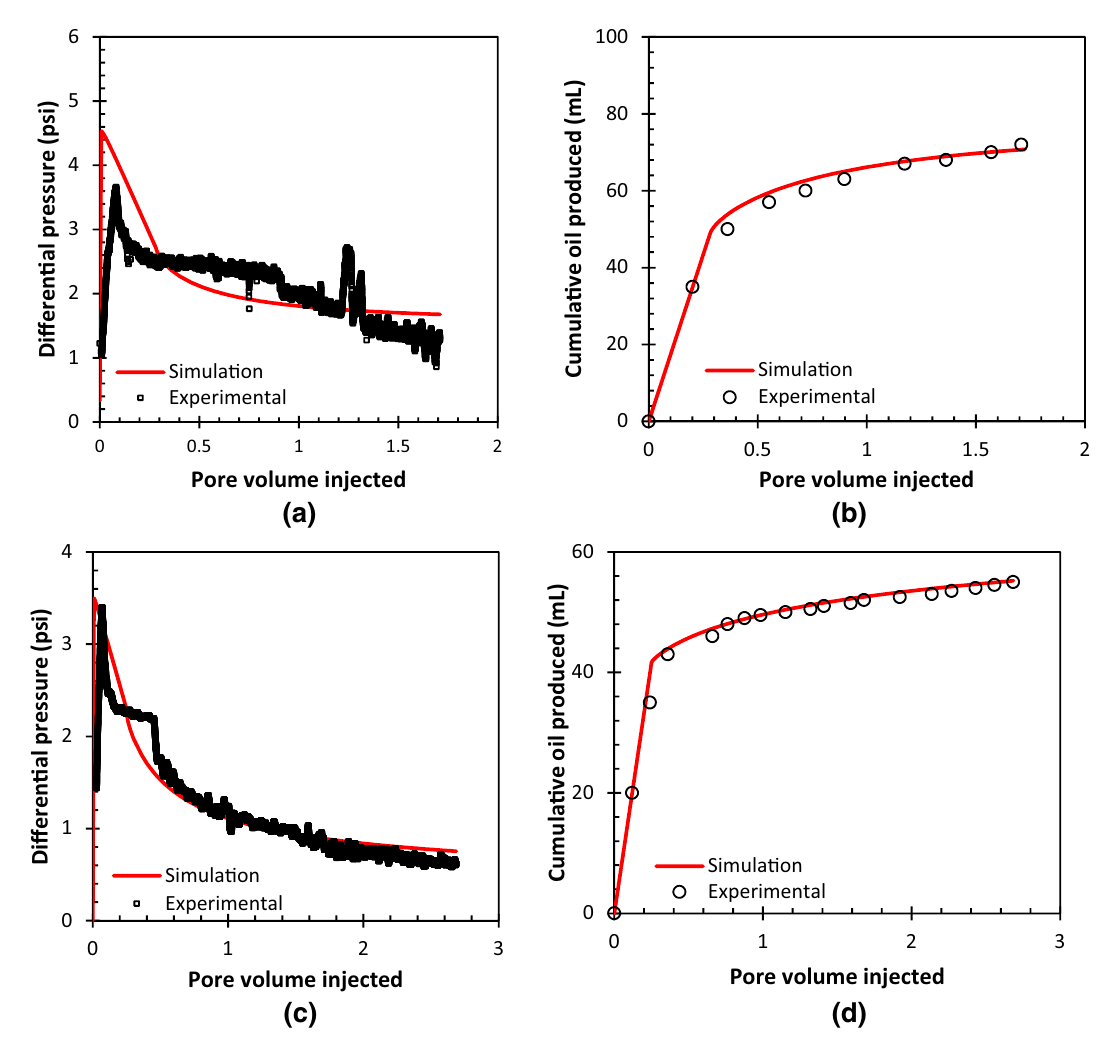
Fig. 10 Differential pressure and associated cumulative oil produced curves matched between experimental data and simulator for differ- ent sandpacks a, b SP8-09-16—heavy oil blend and XG 1000 ppm and c , d SP10-18-12—heavy oil blend and